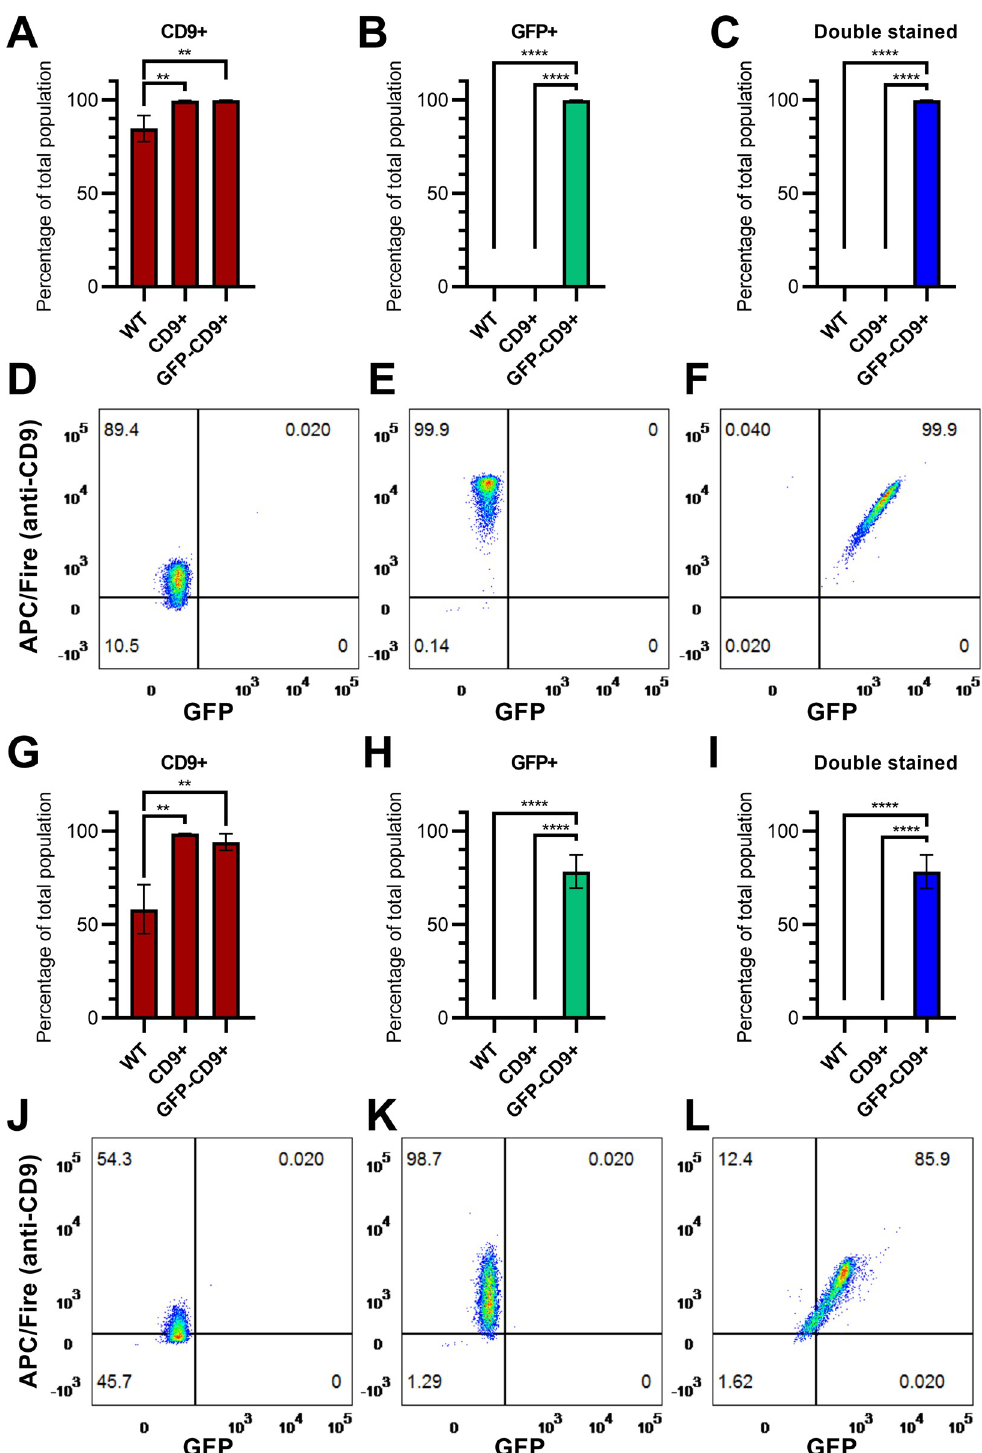
Fig 2. Flow cytometry analysis of EVs. (A) Percentage of CD9+ objects for each cell line after isolation with anti- CD9-beads. (B) Percentage of GFP+ particles after isolation with anti-CD9-beads. (C) Percentage of particles positive for both markers after isolation with anti-CD9-beads. (D) Example of flow cytometry of a EVs sample from WT cells after anti- CD9-beads purification. (E) Example of flow cytometry of a EVs sample from CD9+ cells. (F) Example of flow cytometry of a EVs sample from GFP-CD9+ cells. (G) Percentage of CD9+ particles for each cell line after isolation with anti-